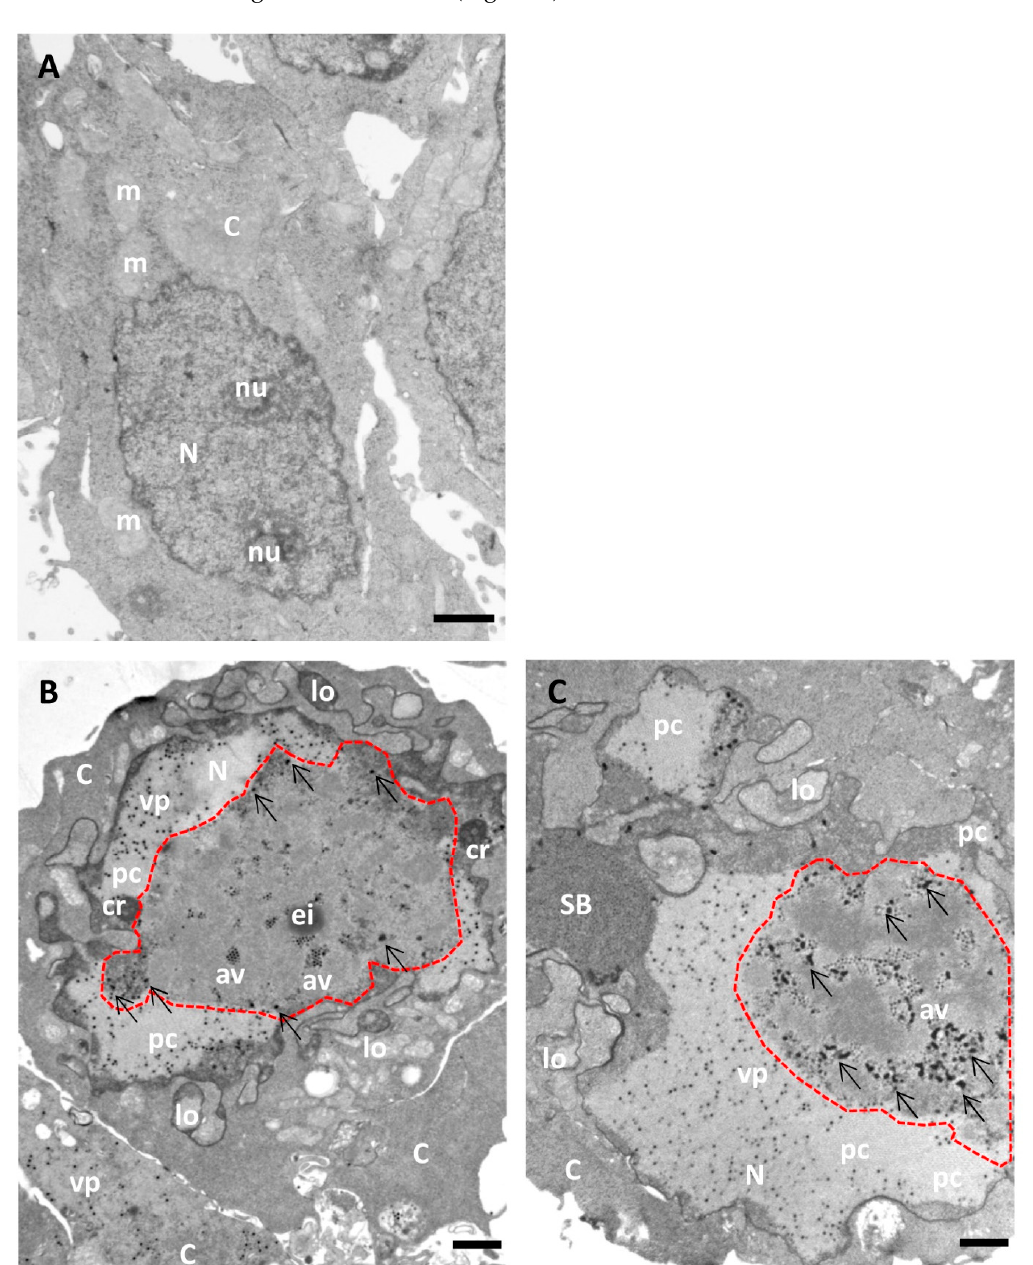
Figure 6. Morphology of AdV-infected cells without BrdU incorporation (for comparison with Figure 7). HEK293 cells uninfected ( A ) or infected with Ad5GL ( B ) or Ad5/FC31 ( C ) in the absence of BrdU. Cells collected at 36 hpi. MOI = 5 (similar structures were observed with MOI = 50). Nucleus (N), nucleolus (nu), cytoplasm (C), lobes (lo), compact ring (cr), electro dense inclusion (ei), protein crystal (pc), array of virus particles (av), viral particles (vp), speckled body (SB), mito- chondria (m), replication center (red dotted line), and electron-dense granules (arrows). Scale bars 1 µm.